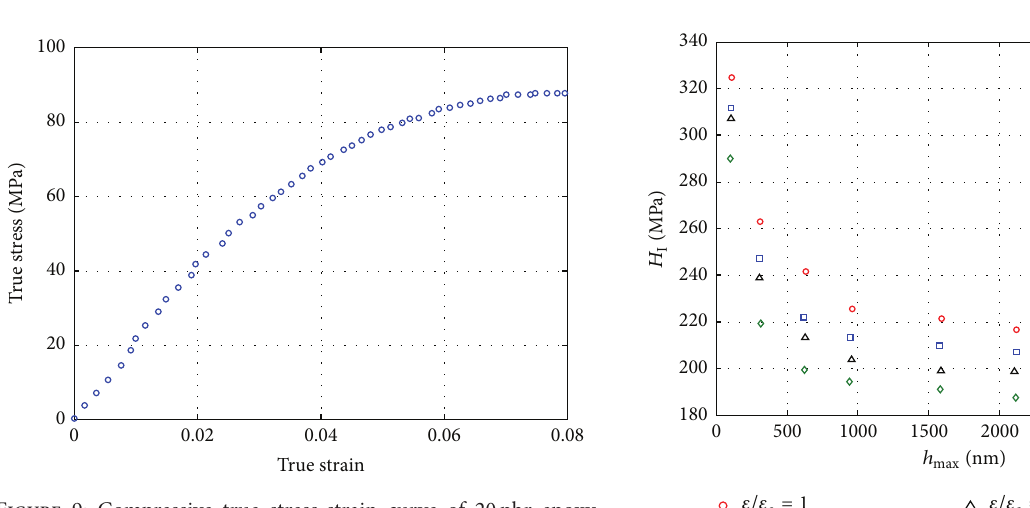
Figure 9: Compressive true stress-strain curve of 20 phr epoxy samples [24].